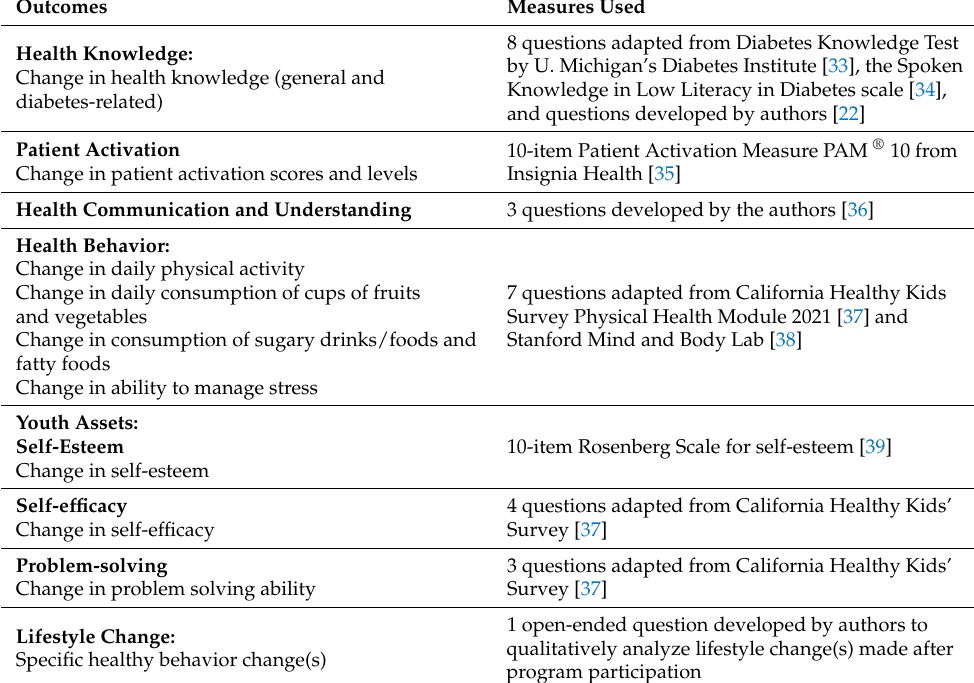
Table 1. Study Outcomes and Measures Used to Assess Outcomes for Participant Surveys Before and After Remote Intervention; San Jose, CA; Lawrence County, MO; and Central Valley, CA, 2020–21. Outcomes Measures Used Health Knowledge: Change in health knowledge (general and